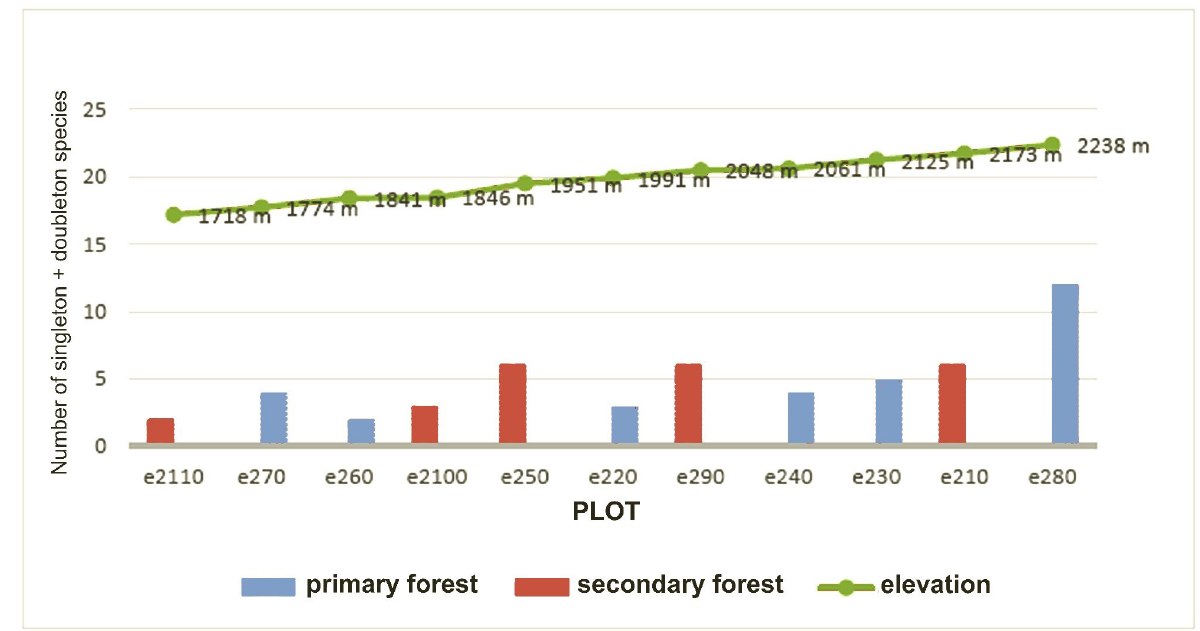
Figure 9. Abundance of singleton + doubleton species in Otonga primary and secondary forest.